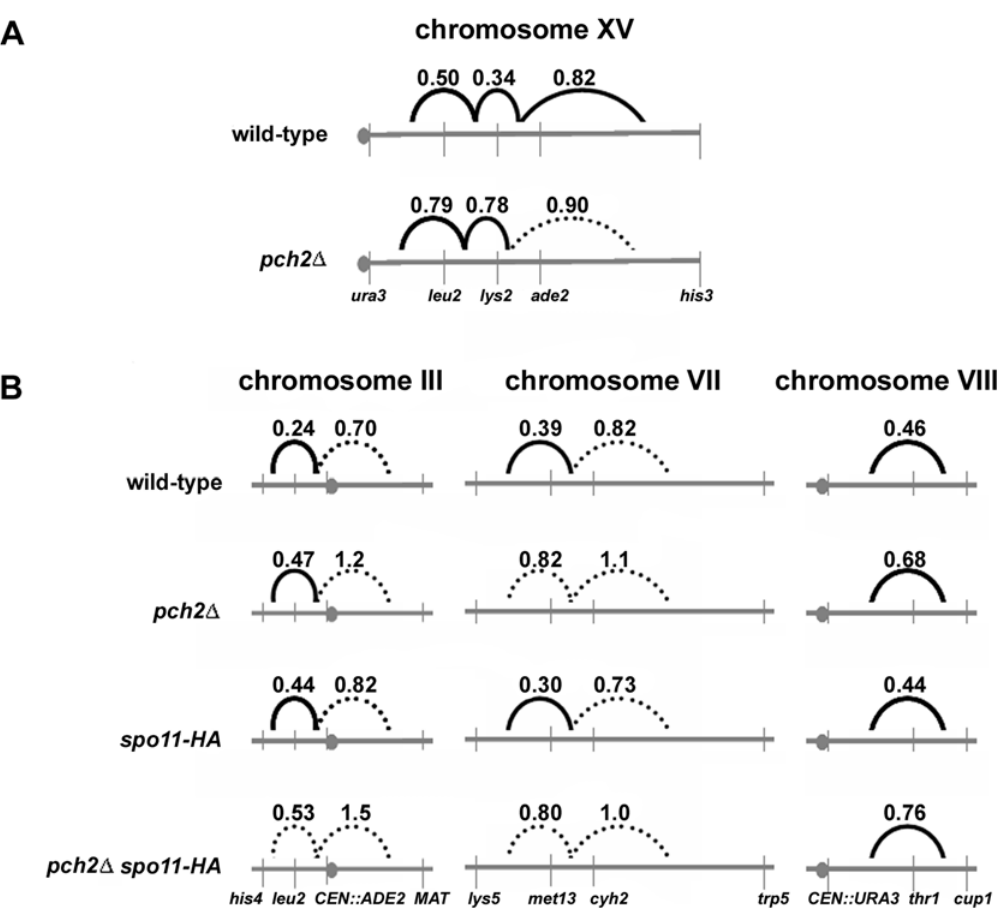
Figure 4. CO interference is reduced in absence of Pch2. Interference was measured using the method of Malkova et al. [32,37] for strains in the EAY (A) and NHY (B) strain backgrounds. For each interval, the map distance was separately calculated for tetrads in which the adjacent interval had ( + ) or did not have ( 2 ) a CO event. If the two map distances are significantly different (G-test), then CO interference is present between the two intervals. The ratio of the CO + to CO 2 map distances gives the strength of the interference, with values nearer to zero indicating stronger interference. The average interference ratio between adjacent genetic intervals is shown above the intervals. Solid lines indicate interference was statistically significant when either interval was used as the reference. The broken lines indicate interference was not statistically significant when one or both intervals were used as the reference. See Table S2 for raw data and statistical analyses.